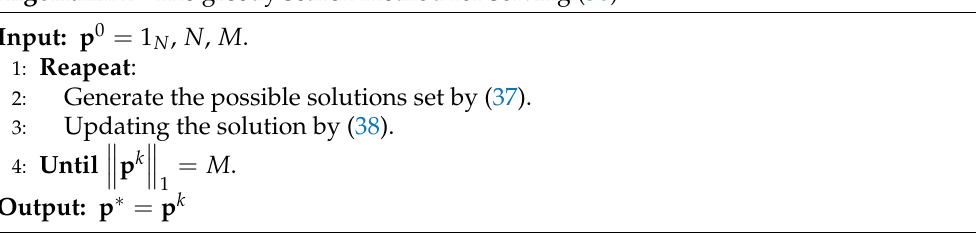
Algorithm 2 : The greedy search method for solving